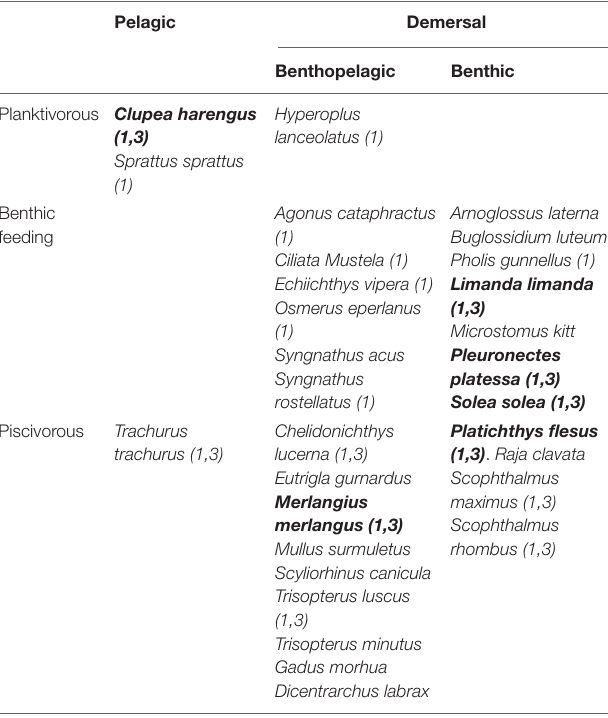
TABLE 1 | Top 30 species based on catch numbers on Sea Beam Trawl Survey (BTS) and Demersal Young Fish Survey (DYFS) in the southern North Sea, and used to establish selection criteria for the implementation of a microplastics biomonitoring